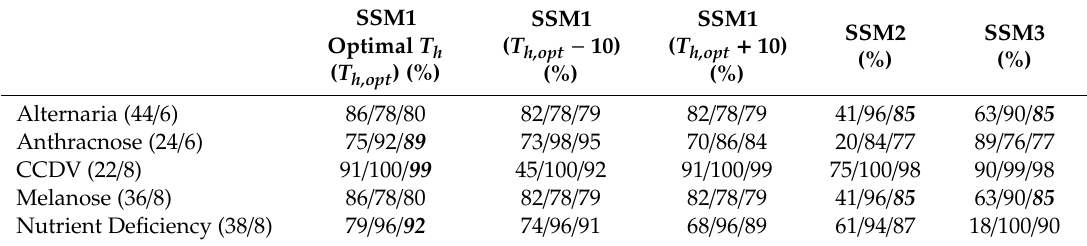
Table 2. Sensitivity / specificity / accuracy of group A. The parentheses next to the name of the diseases denote (test / training samples). The SSM with the best accuracy for each disease is highlighted with bold-italics.